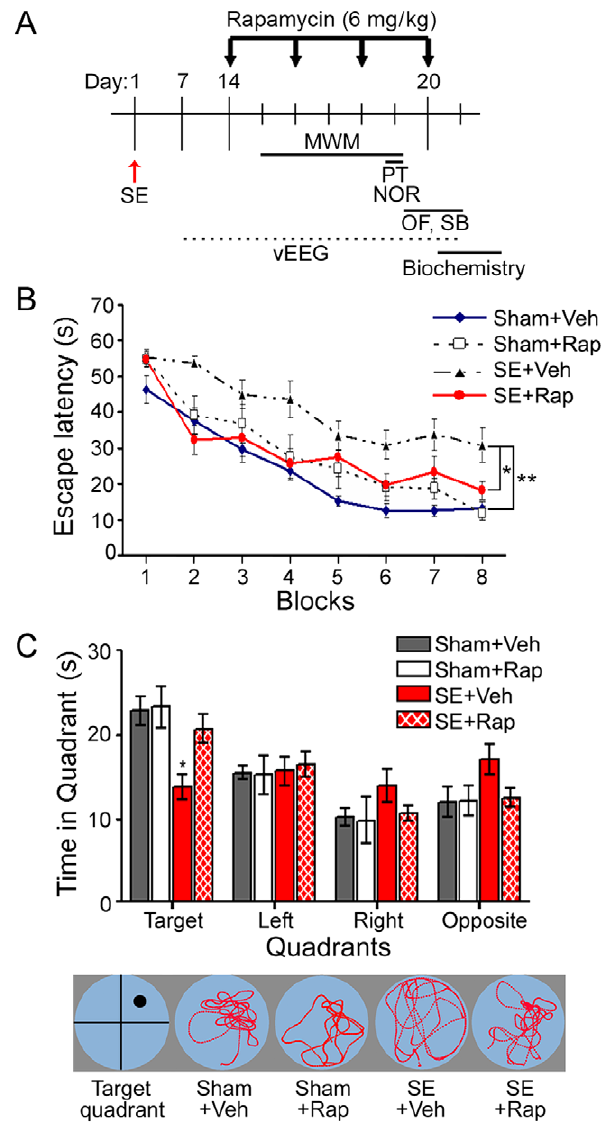
Figure 1. Rapamycin improved spatial learning and memory in rats subjected to SE. ( A ) The timeline of SE induction (day 1), rapamycin (Rap) treatment (6 mg/kg; days 14, 16, 18 and 20), Morris water maze (MWM) training (days 15–19), probe test (PT) (day 19), novel object recognition (NOR) (day 19) (Fig. 2), social behavior (SB) and open field (OF) (days 20–21), video-electroencephalogram (vEEG) recordings (between 7–21 days after SE), and hippocampi dissection for bio- chemical analyses is shown. ( B–C ) MWM results for the four experimental groups. ( B ) The rats were trained over 8 blocks (2/day, 4 days) to find a hidden platform (target quadrant) in opaque water using visual cues (acquisition phase). The time to find the hidden platform (escape latency) was significantly longer in the SE + Veh compared to the Sham + Veh group. There was no difference in the SE + Rap, Sham + Veh, and Sham + Rap groups. ( C , top panel) The hidden platform was